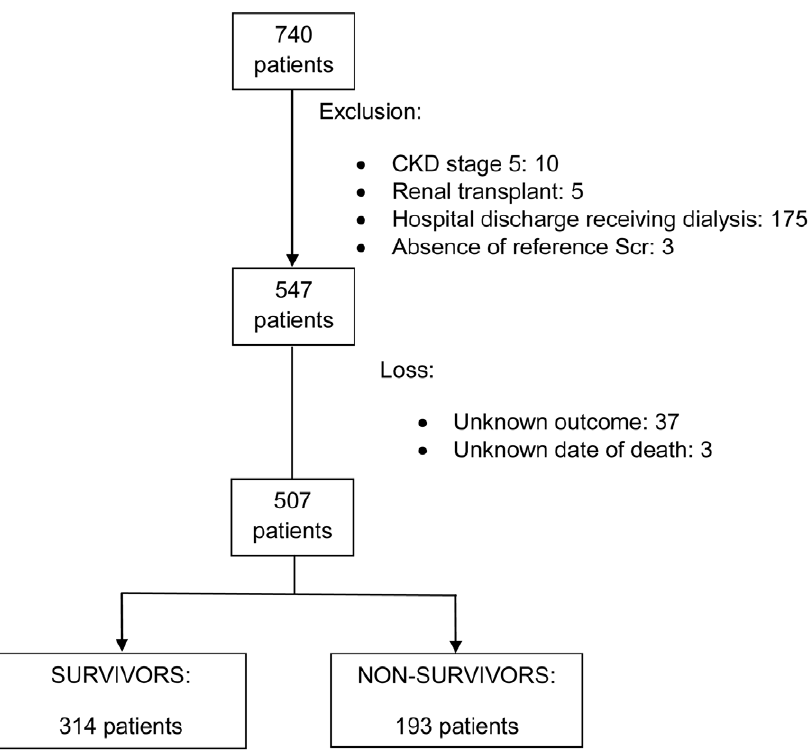
Figure 1. Flow-chart showing the selection process. CKD: chronic kidney disease Scr: serum creatinine.